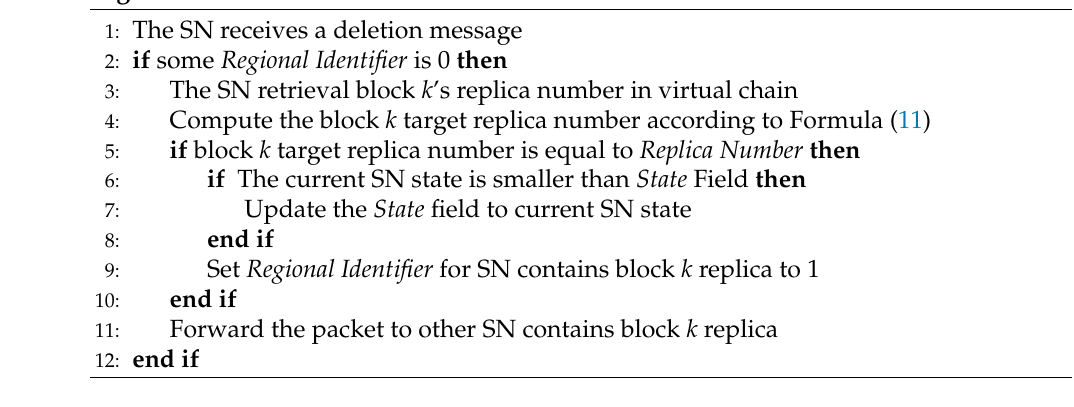
Algorithm 2 Block deletion state interaction.